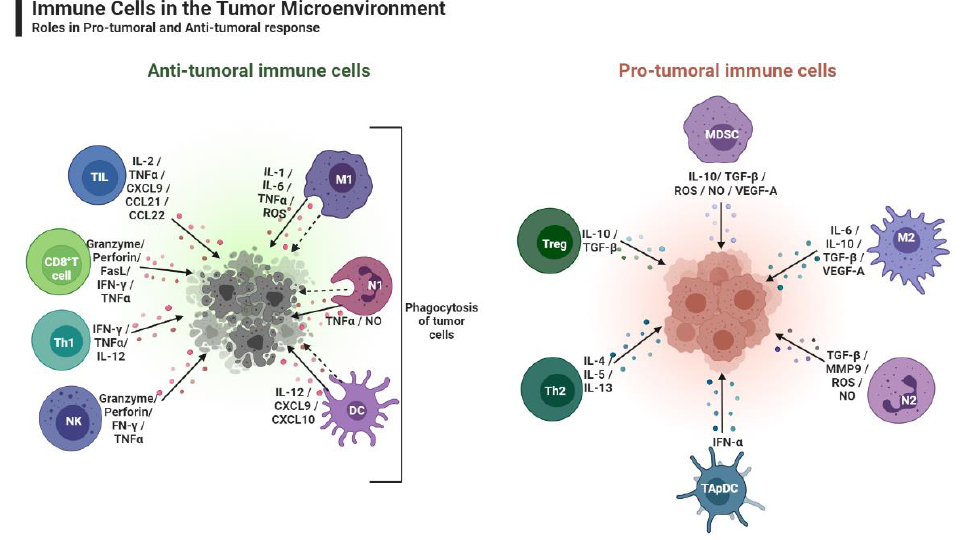
Figure 3. The role of Immune Cells in the tumor microenvironment, created by Biorender.com (accessed on 26 August 2022). On the left is represented the immune cells that act as tumor killers by the production of cytokines or by phagocytosis, that can destroy tumor cells, and on the right, the cells that contribute to immune suppression. TIL- Tumor Infiltrating Lymphocytes; CD8 + T—cytotoxic T